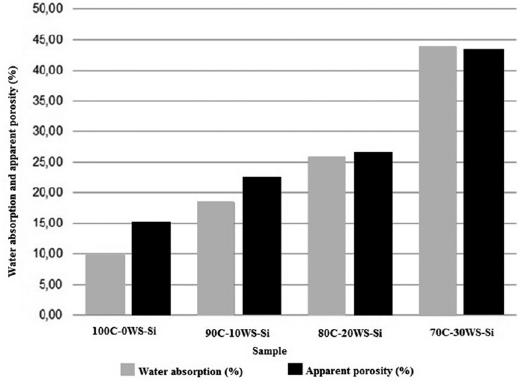
Figure 4: Water absorption and apparent porosity of calcined aggregates made with clay and wood sawdust and sodium silicate, fired out at 900ºC